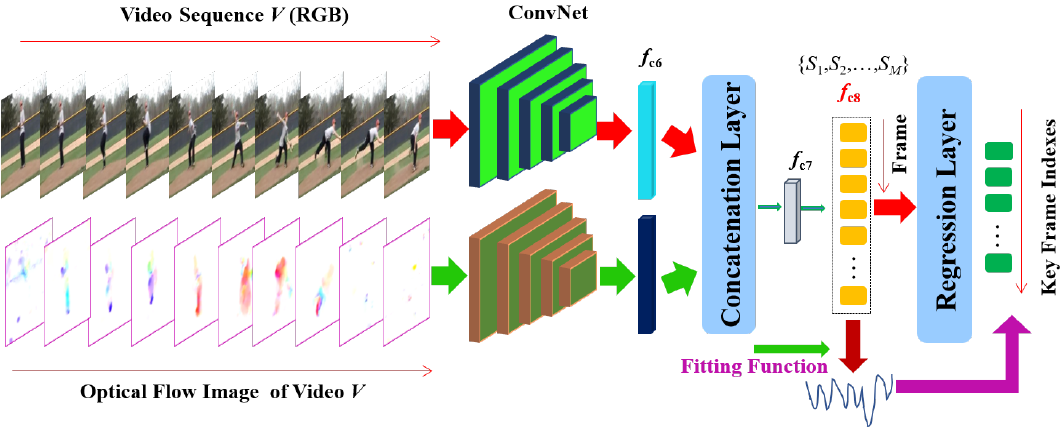
Figure 2. An overview of the deep key frame detection framework. The appearance network operates on RGB frames, while the motion network operates on the optical flow represented as images. The feature maps from the appearance and motion ConvNets are aggregated to form a spatio-temporal feature